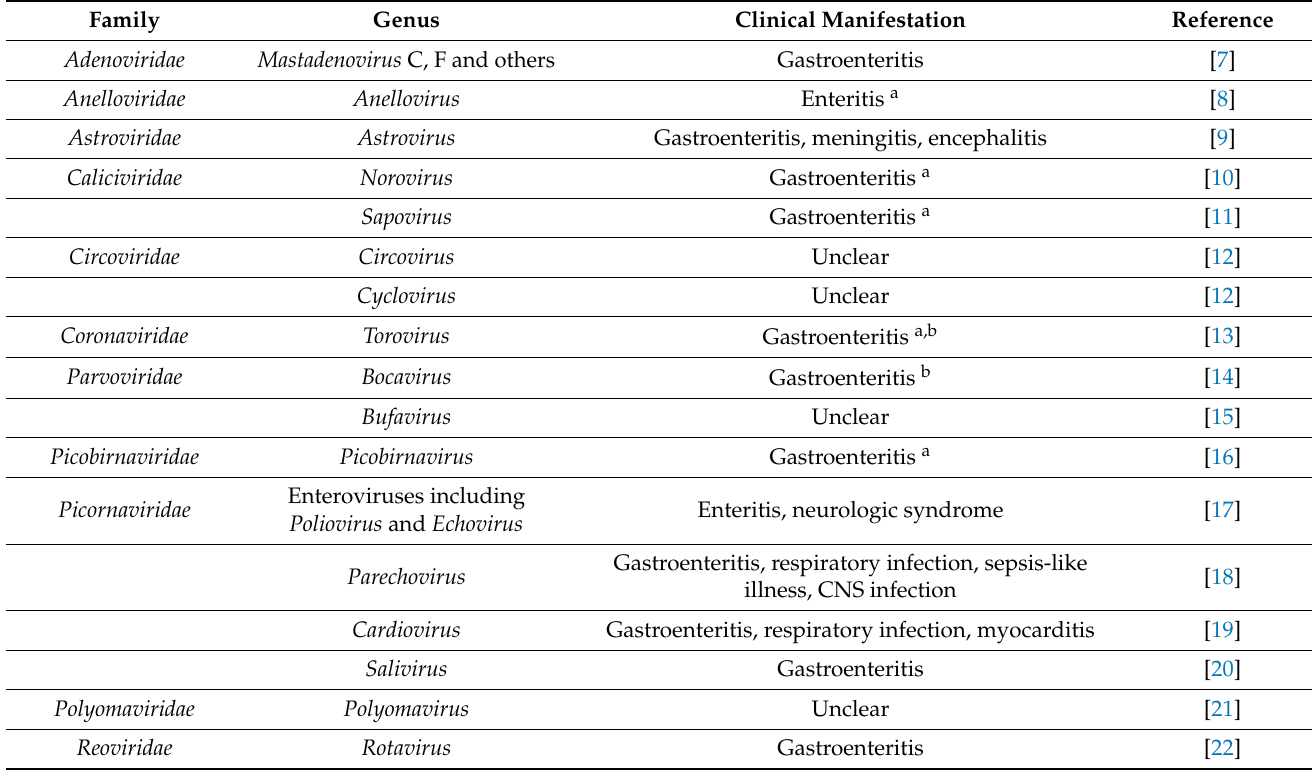
Table 1. Eukaryotic viruses of the gastrointestinal microbiota. Adapted from [7–22]. (a) This type of virus is also detected in healthy/asymptomatic hosts. (b) The etiologic role of this virus in human gastroenteritis remains uncertain.